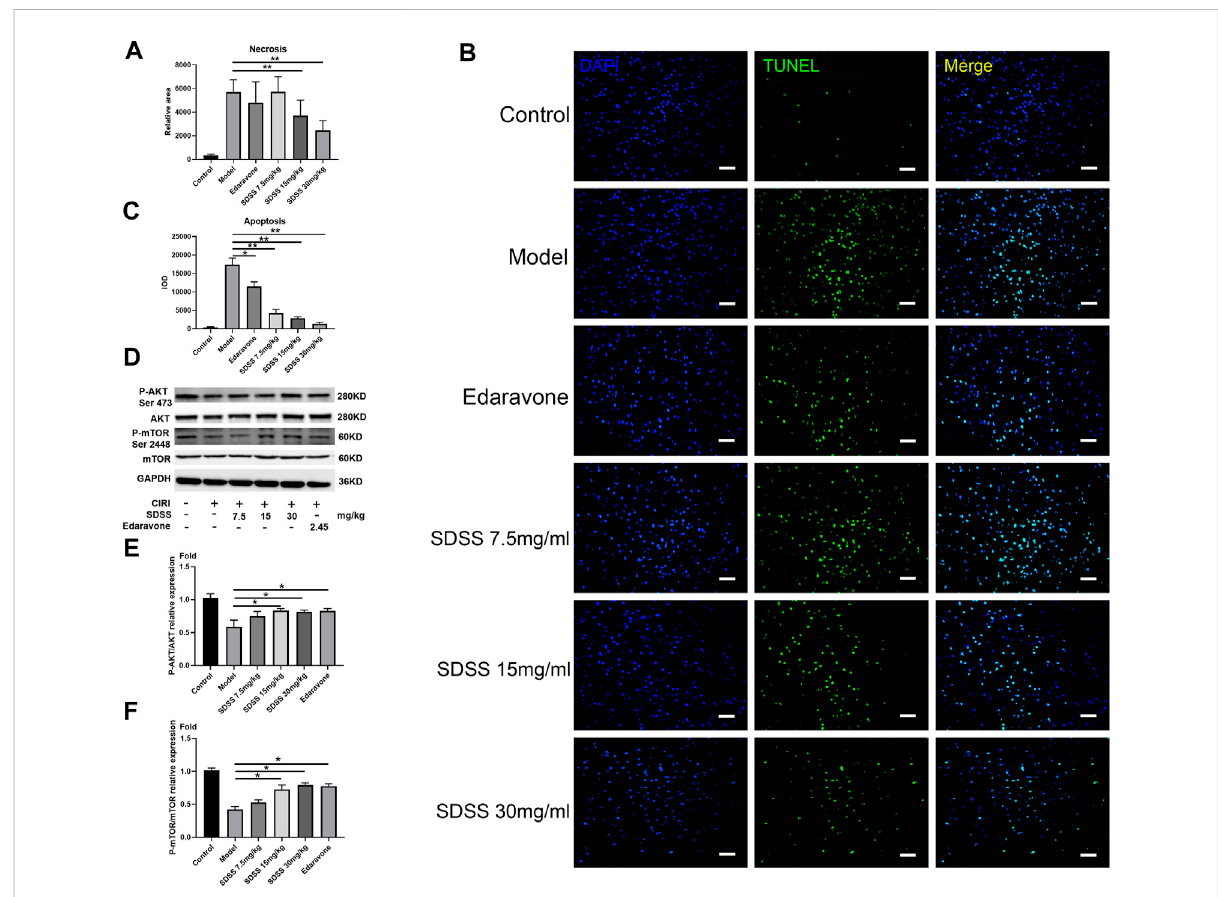
FIGURE 6 SDSSpreventsapoptosisinratsafterCIRI. (A) Thenecrosisarea(calculatedfromFigure6D)inthebraintissue. (B) TUNELstainingofbraintissues after ischemia/reperfusion in each group. (C) Apoptosis level in the brain samples. (D) Expression levels of p-mTOR (ser2448) and p-AKT (ser473) in the brain samples, as shown by Western blot. Quanti fi cation of the expression levels of (E) p-AKT (ser473) and (F) p-mTOR (ser2448) in brain tissues. Number of replicates = 3. * = p < 0.05; ** = p <